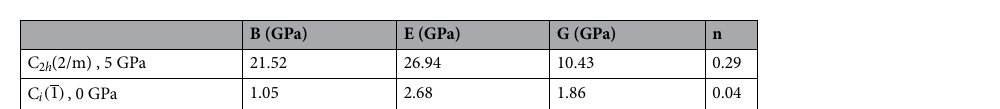
Figure 4. The N 6 –N 2 system Calculated phonon dispersion along the high symmetry points of the first Brillouin zone, the predicted Raman and the IR spectra at 5 GPa [( a ) , ( b ) and ( c ), respectively]. The same properties of N 6 –N 2 at 0 GPa [( d ), ( e ) and ( f ), respectively].